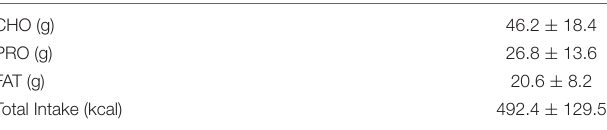
TABLE 1 | Dietary intake and macronutrient distribution pre-exercise. CHO